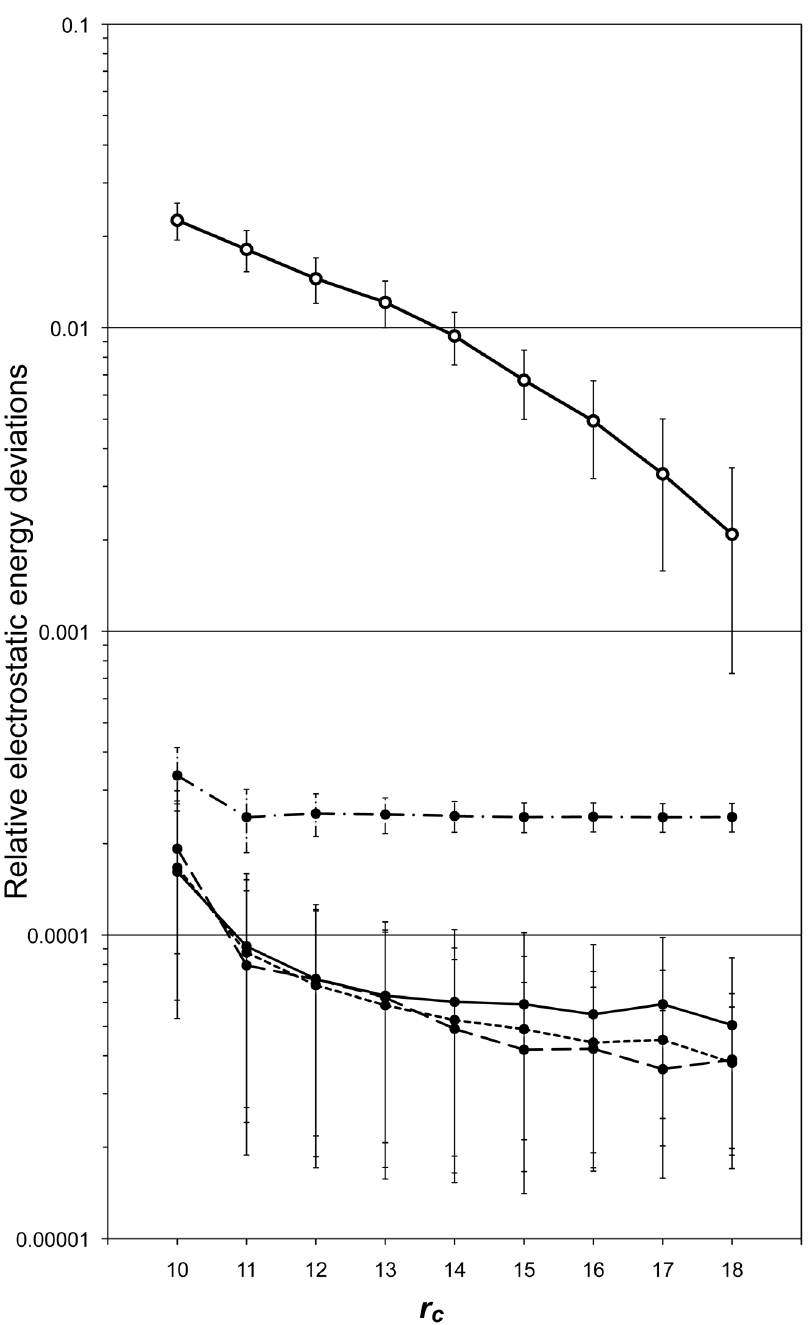
Figure 2. Relative electrostatic energy deviations by the ZD and RESA methods with the cutoff distance r c , averaged for 1,000 sampled structures produced by MD with the PME method, compared with those calculated by the Ewald method (Eq. 5). The thin solid line, dotted line, dashed line, and dash-dotted line with filled circles are the results from the ZD method with damping factor a values = 0.0, 0.06, 0.10, and 0.14 (A˚ 2 1 ), respectively. The thick solid line with open circles represents the results from the RESA method. The error bars are the standard deviations for 1,000 samples.